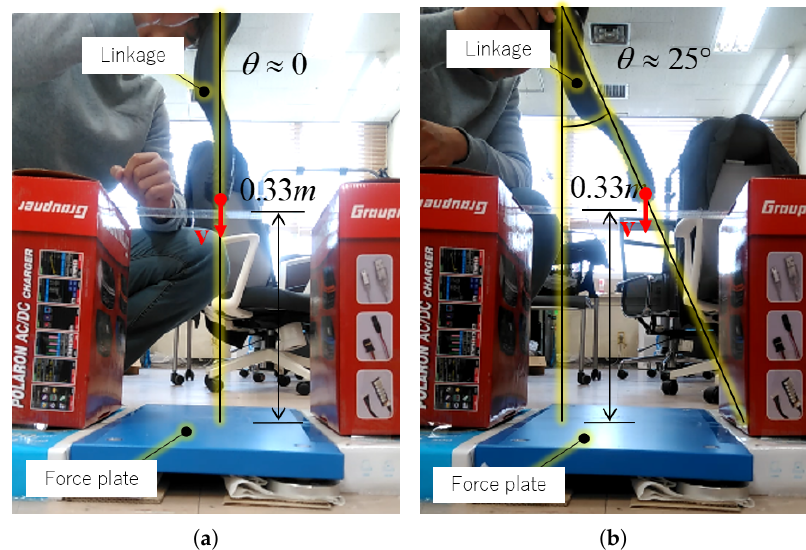
Figure 5. Linkage drop test: ( a ) with no angle; ( b ) with an angle.